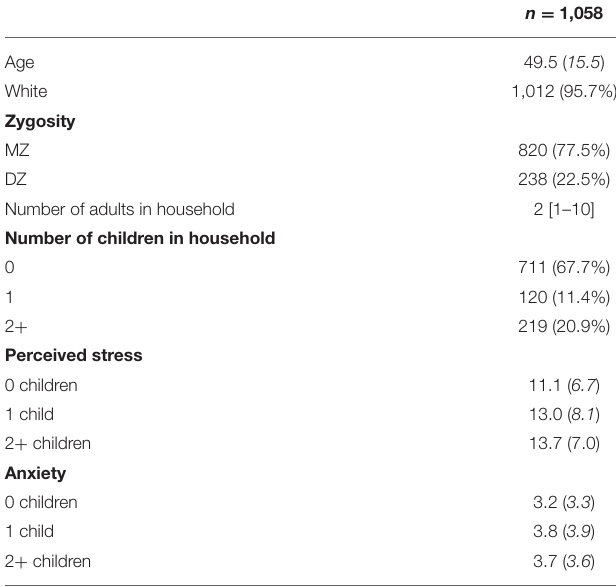
TABLE 4 | Descriptive statistics of select demographic characteristics, number of children and adults in household, perceived stress, and anxiety in the Washington State Twin Registry (WSTR) same-sex twins sample in study